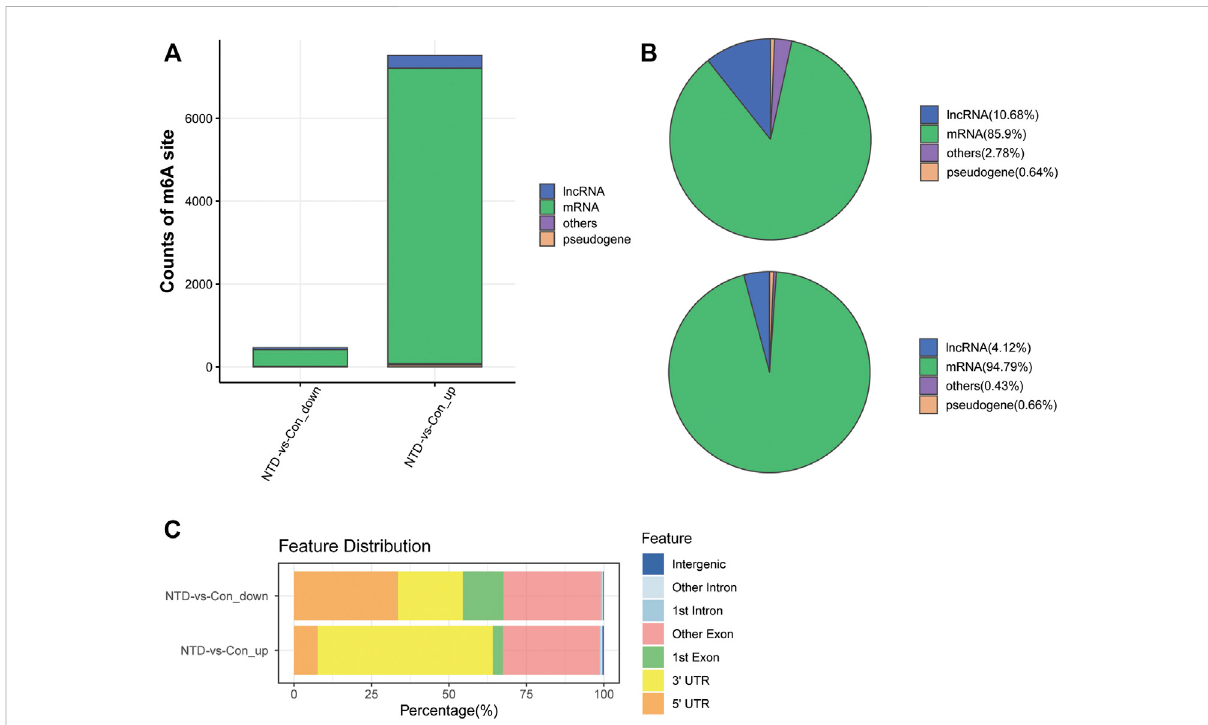
FIGURE 2 Analysis ofdifferentially methylated m 6 A sitesbased onMeRIP-seq data. (A) Counts ofdifferentiallymethylated m 6 A sitesbetween